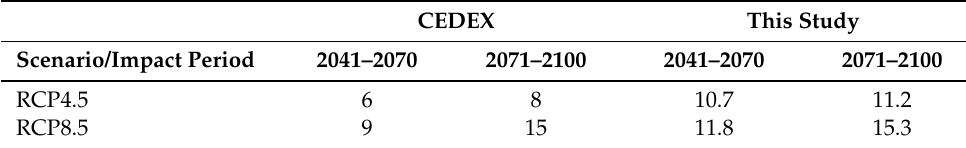
Table 3. Comparison of the average variation (%) estimated in the present work and in CEDEX [45] for the entire DHS for the 2 scenarios and the 2 periods used. The variations are referred to the control periods 1961–2000 in CEDEX [45] and 1971–2000 in the case of the present study. CEDEX This Study Scenario/Impact Period 2041–2070 RCP4.5